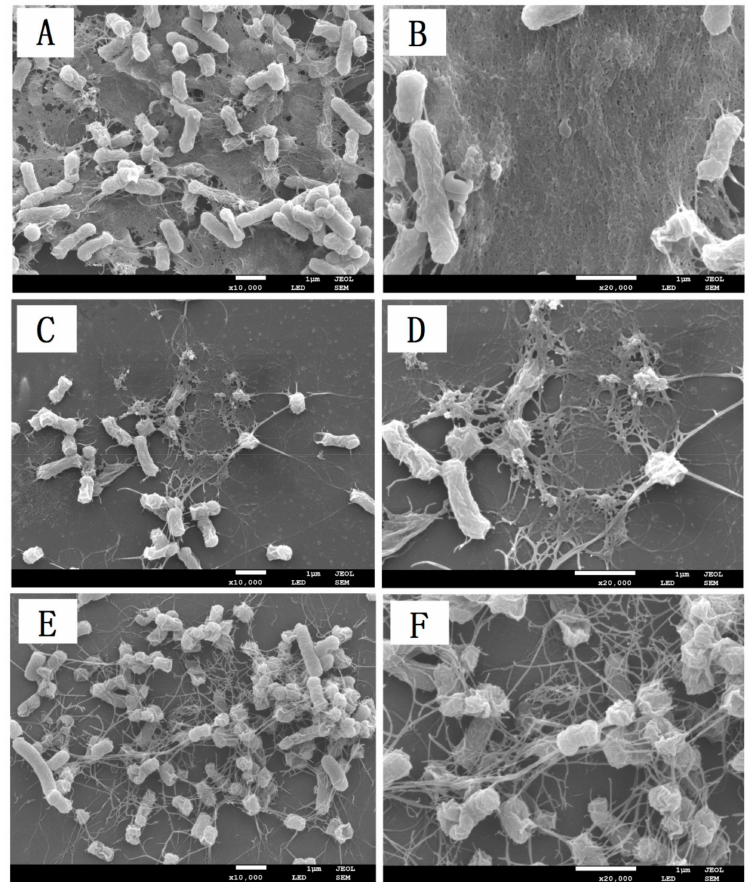
Figure 6. E ff ects of BITC on biofilm formation of S. typhimurium at di ff erent concentrations. S. typhimurium was added with BITC at 1 / 4 MIC ( C , D ) or 1 / 8 MIC ( E , F ) in 6-well plates and cultured for 36 h. MH instead of BITC was used as negative control ( A , B ). The samples were observed under SEM, and the images were collected at 10000 × ( A , C , E ) and 2000 × ( B , D , F )